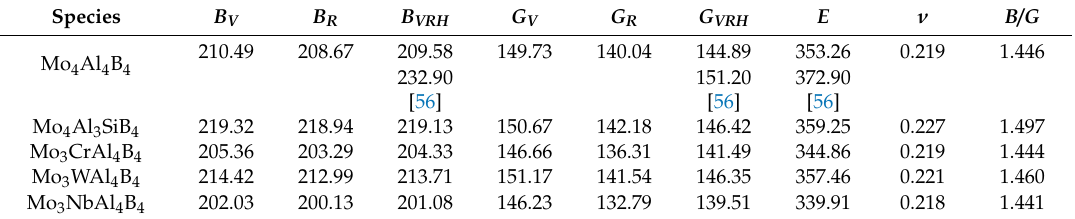
Table 3. The elastic moduli (GPa), Poisson’s ratios, and B / G ratios (dimensionless).